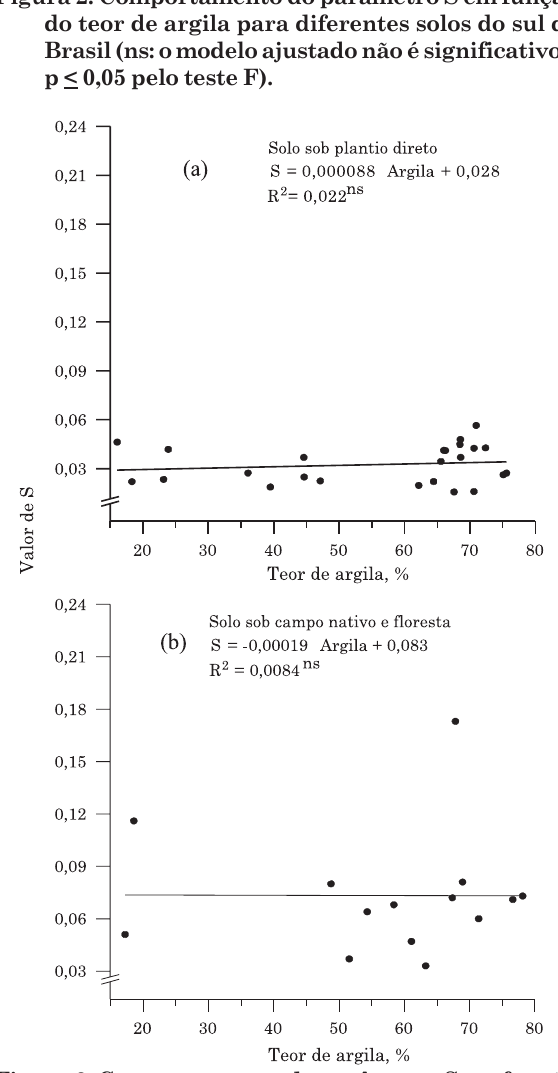
Figura 3. Comportamento do parâmetro S em função do teor de argila para solos sob diferentes sistemas de manejo (ns: o modelo ajustado não é significativo a p < 0,05 pelo teste